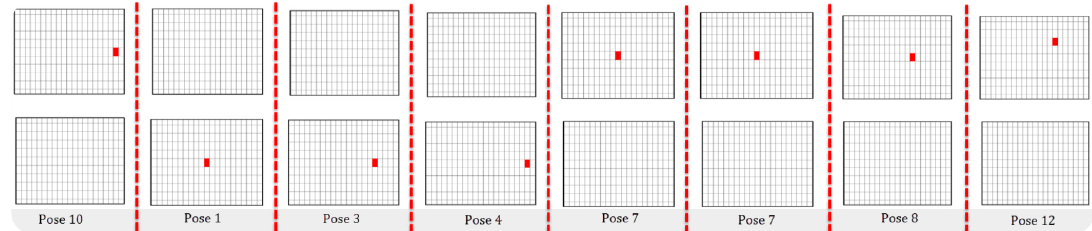
Figure 17. Selected poses for an Action Time of 0.1 s.